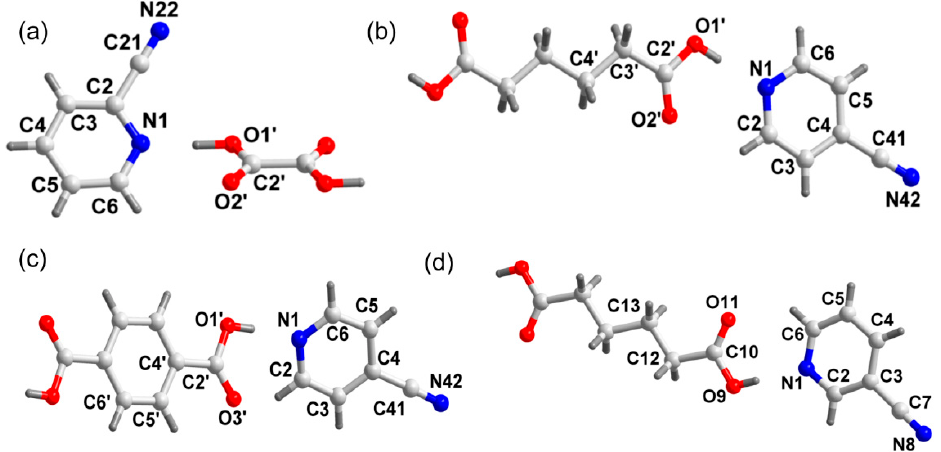
Figure 1. Molecular structures of ( a ) (ox) 0.5 (2-CNpy) ( 1 ), ( b ) (adp)(4-CNpy) 2 ( 2 ), ( c ) (tp)(4-CNpy) 2 ( 3 ) and ( d ) (adp)(3-CNpy) 2 ( 4 ).